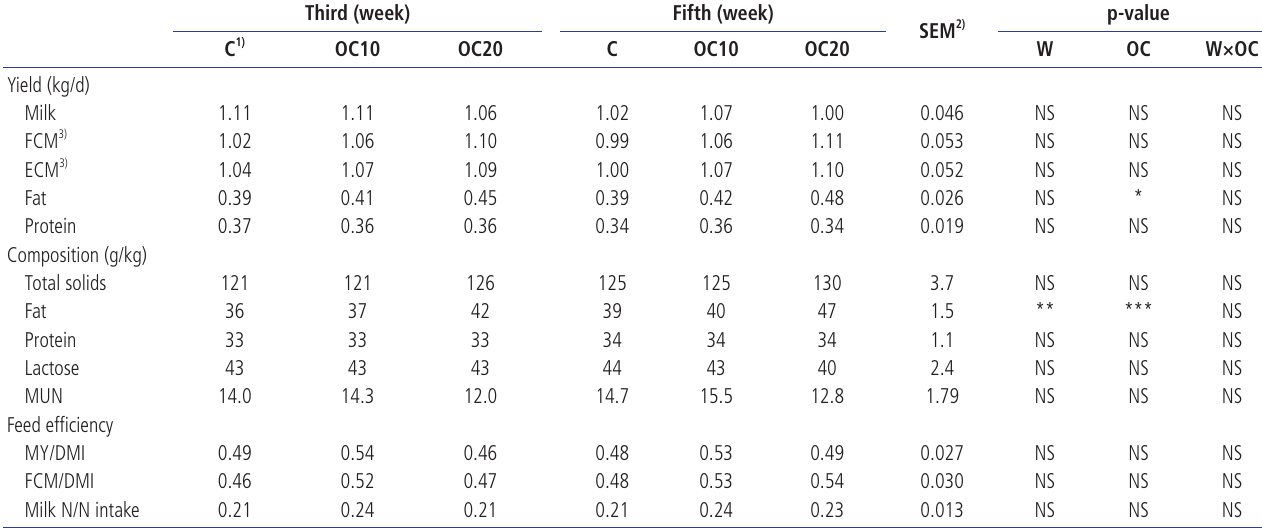
Table 4. Effect of dietary treatments and sampling time (third and fifth week of the experiment) on milk yield, compositon and feed effiencies of dairy